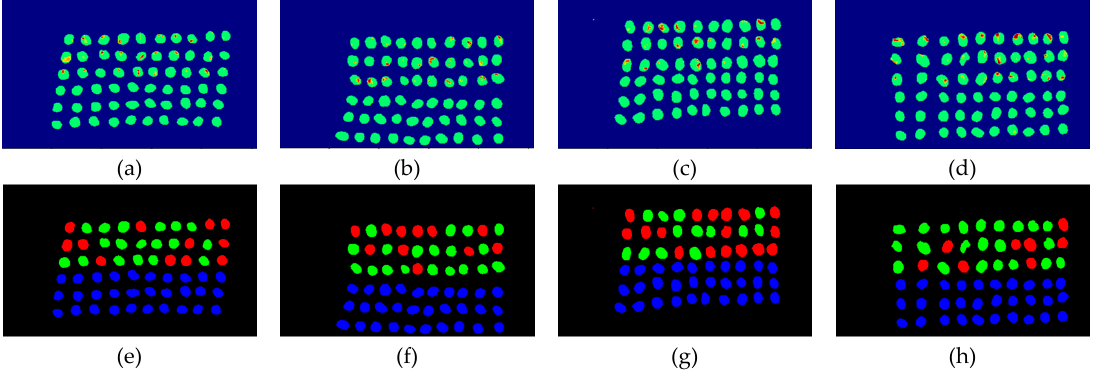
Figure 36. Results of green coffee bean CNN+SB_CTBS 10 bands. (a-d) CNN classification results, (e- h) final visual images.